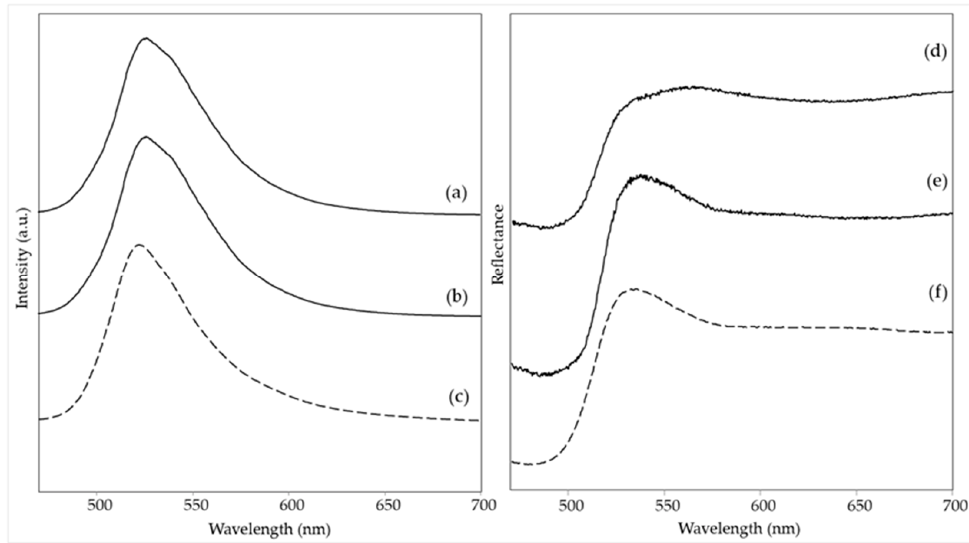
Figure 4. ( Left ) Emission spectra ( λ exc = 435 nm) of yellow areas: ( a ) The North pole and the tree of life , area 5, ( b ) Earthquake , area 2 and ( c ) reference sample of Y173. ( Right ) Visible reflectance spectra of yellow areas: ( d ) The North pole and the tree of life , area 5, ( e ) Earthquake , area 2, and ( f ) reference sample of Y173. Legend: (solid lines) spectra acquired on the paintings; (dashed lines) spectra of the reference fluorescent paint.